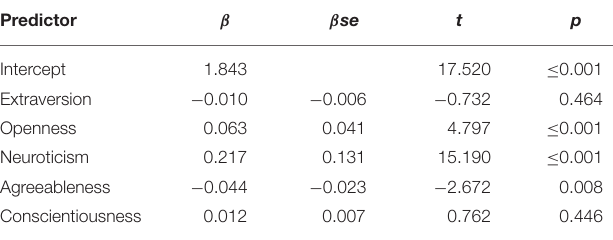
TABLE 5 | Regression analysis to predict the DSB by the Big Five traits. Predictor